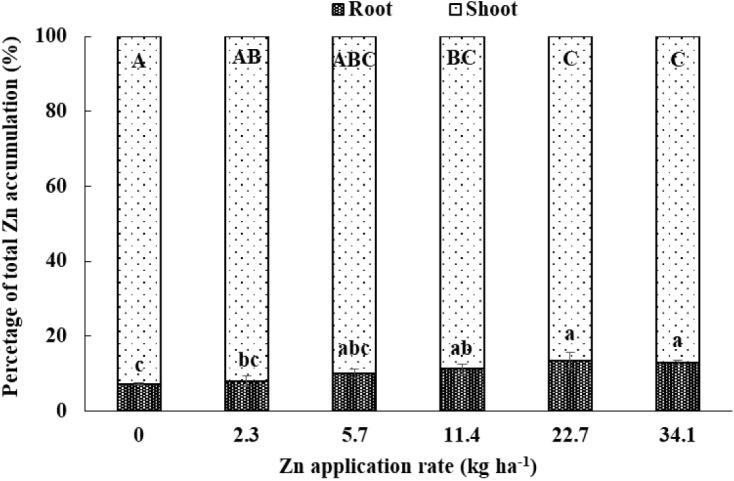
Zinc accumulation in root and shoot as a percentage of total (root + shoot) Zn accumulation at the anthesis stage of winter wheat as affected by Zn application rate in the 2013–2014 cropping season. Values are average + SE of four replications. Same lowercase letters indicate no significant differences (P < 0.05) among treatments for root Zn accumulation relative to total Zn accumulation. Same uppercase letters indicate no significant differences (P < 0.05) among treatments for shoot Zn accumulation relative to total Zn accumulation.